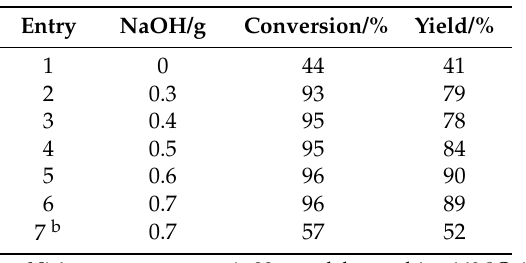
Table 1. Conversion of cyclohexanol into cyclohexylamine over Raney Ni in aqueous ammonia with different amount of NaOH a .